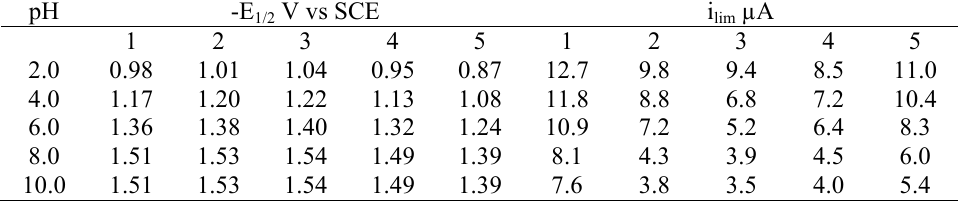
Table 1. Polarographic data of compounds 1-5 Conc. = 1 mM, Medium = 65% (V/V) DMF. pH -E V vs SCE 1/2